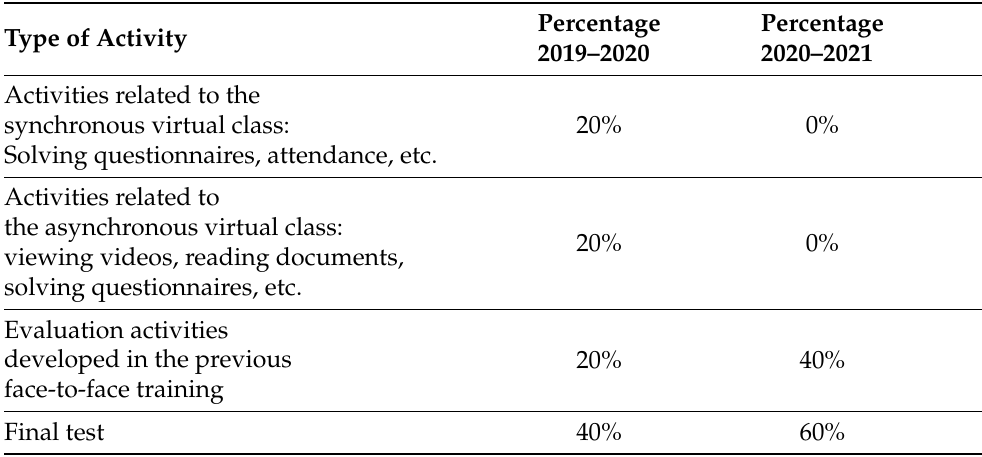
Table 4. Percentages of teaching